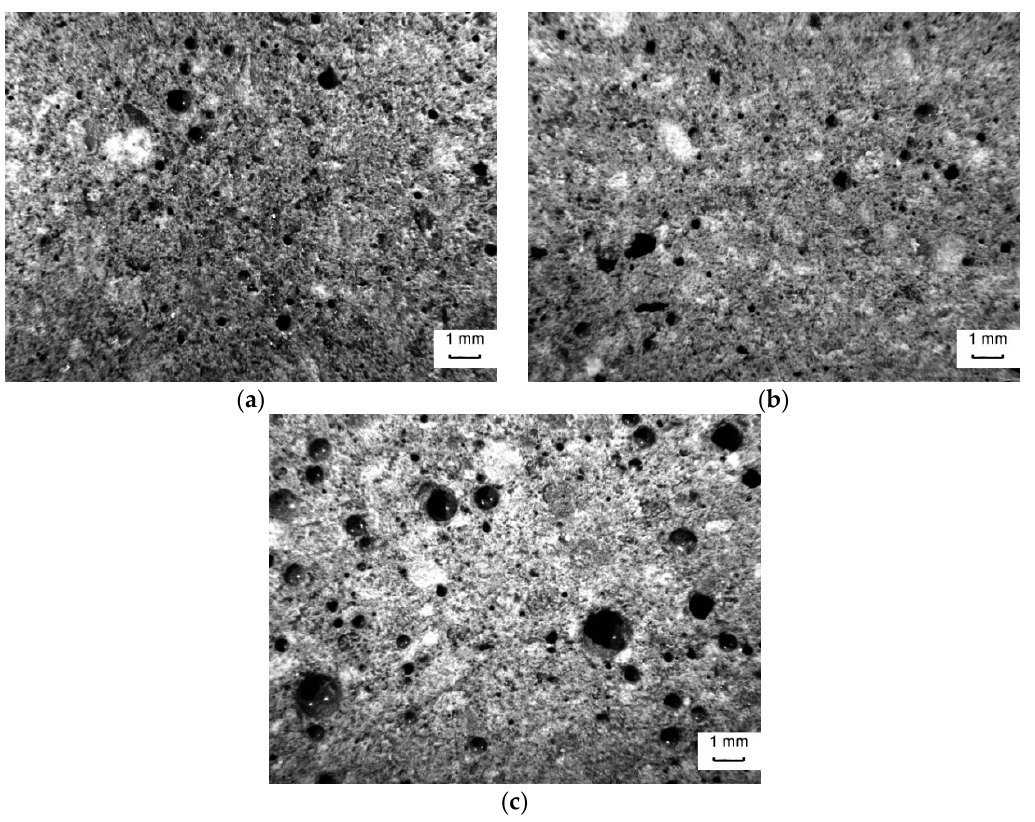
Figure 5. Optical images of geopolymer mortars after 28 days of curing: ( a ) PCE_1; ( b ) ACRa_06; and ( c ) GP. (Magnification 8×).